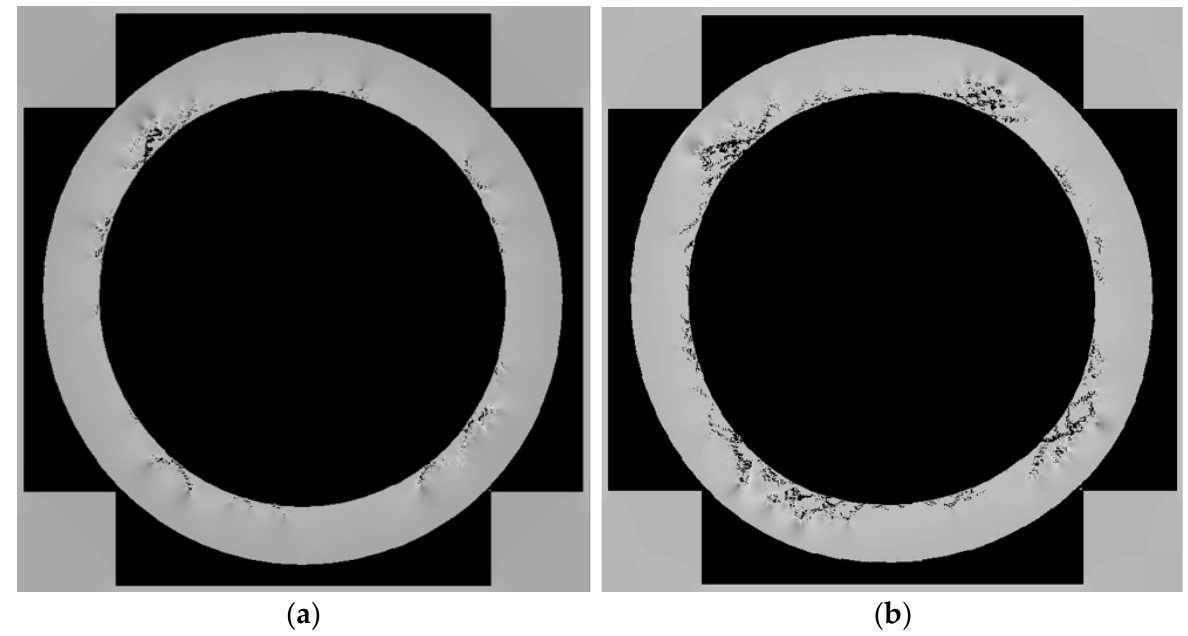
Figure 25. S1ZK0 + 660 m lining damage diagram. ( a ) Uniform pressure (step 11-2); ( b ) Non-uniform pressure (step 13-1).